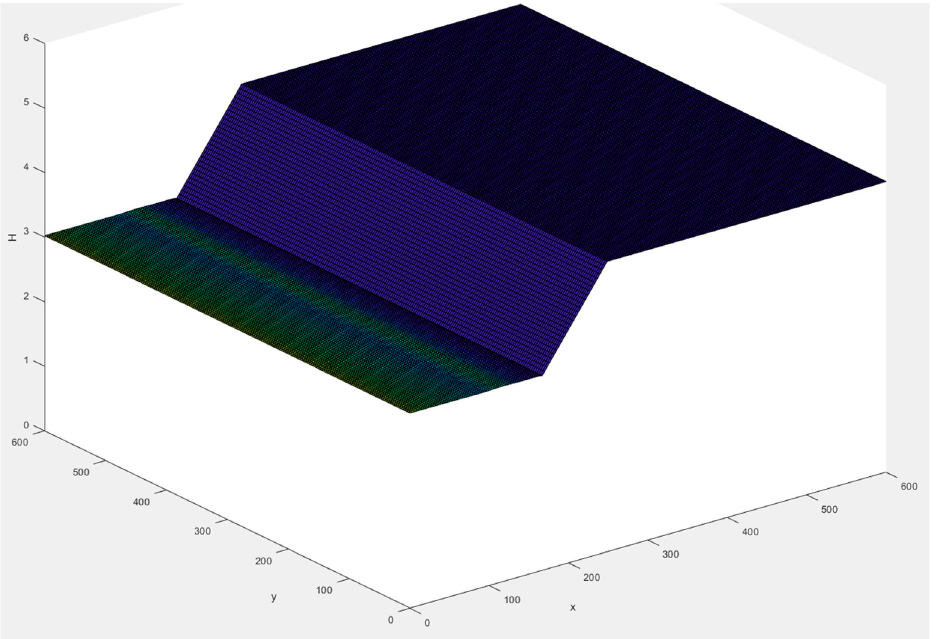
Figure 6. Illustration of the water levels (in green) and bathymetry (in purple).